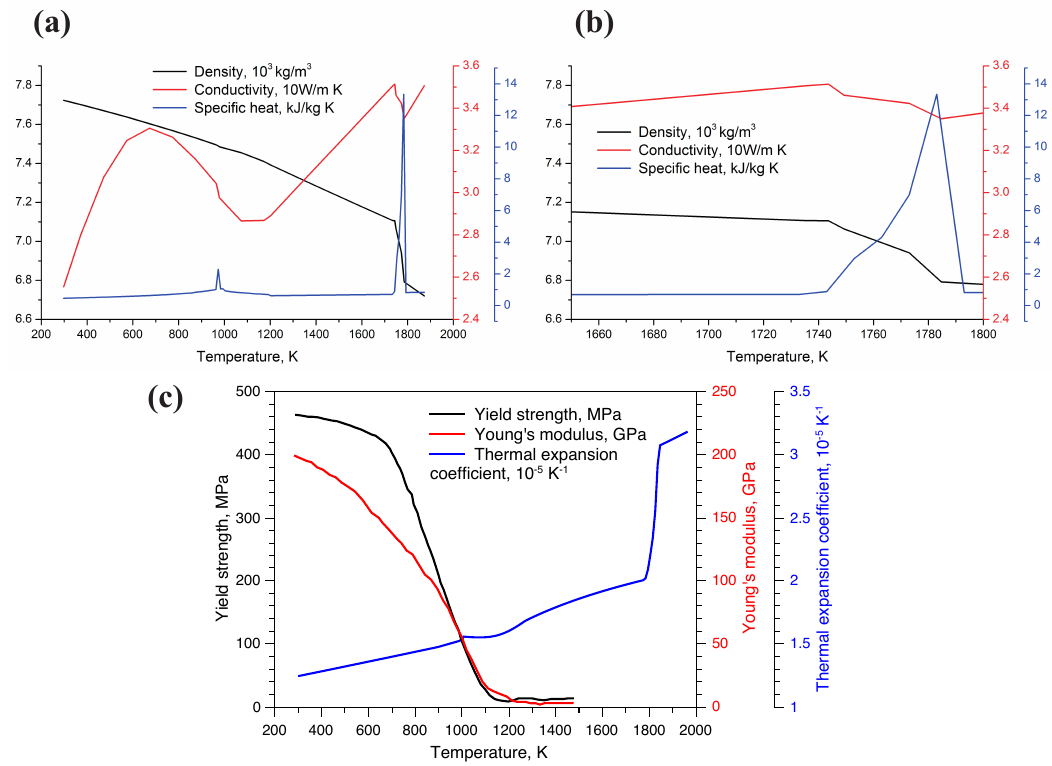
Figure 5. ( a ) Thermophysical material properties, ( b ) thermophysical material properties used in the mushy zone and ( c ) temperature-dependent mechanical